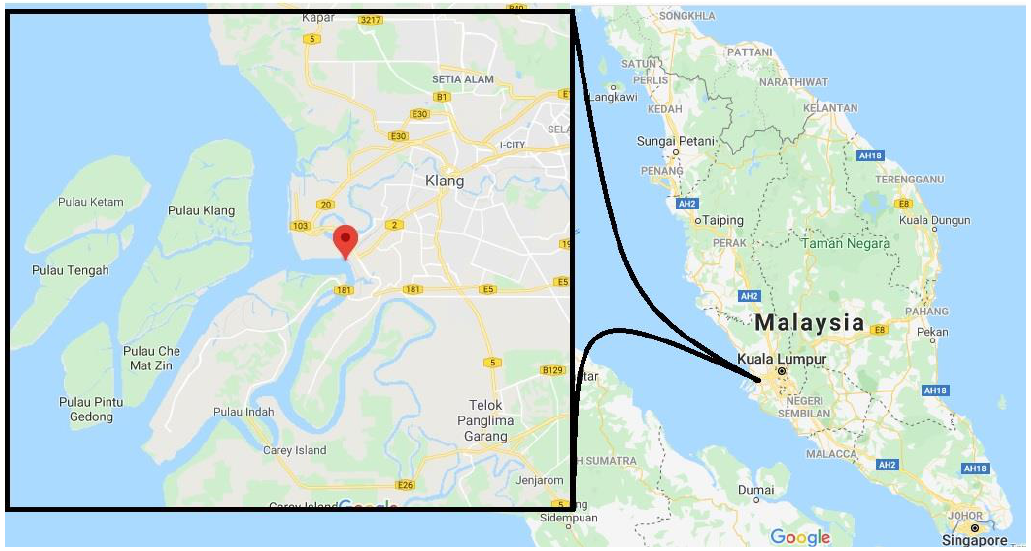
Figure 1. Location of marine water sampling (Source: Google Earth image).